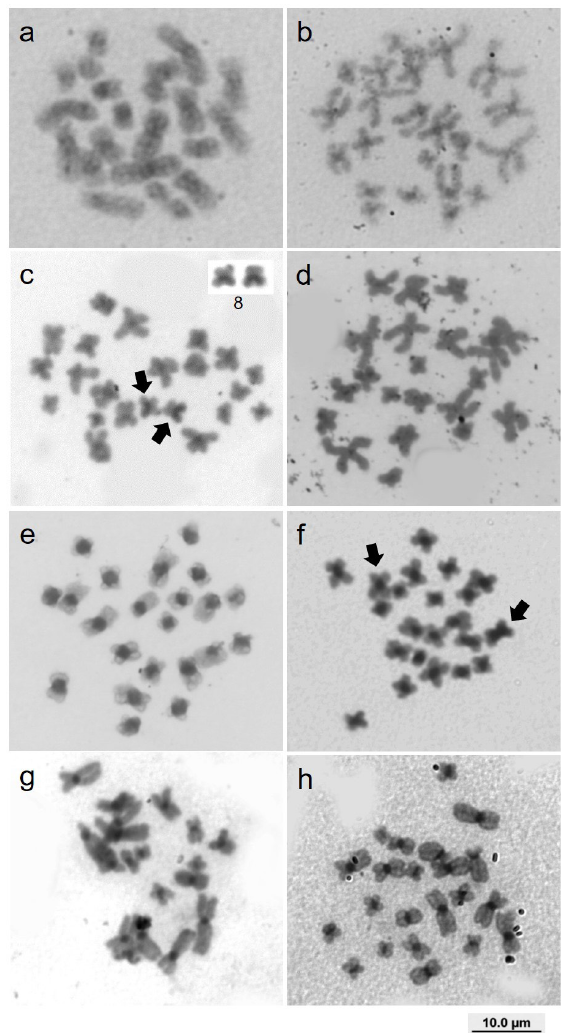
Figure 3. C-banding in Proceratophrys species. a)